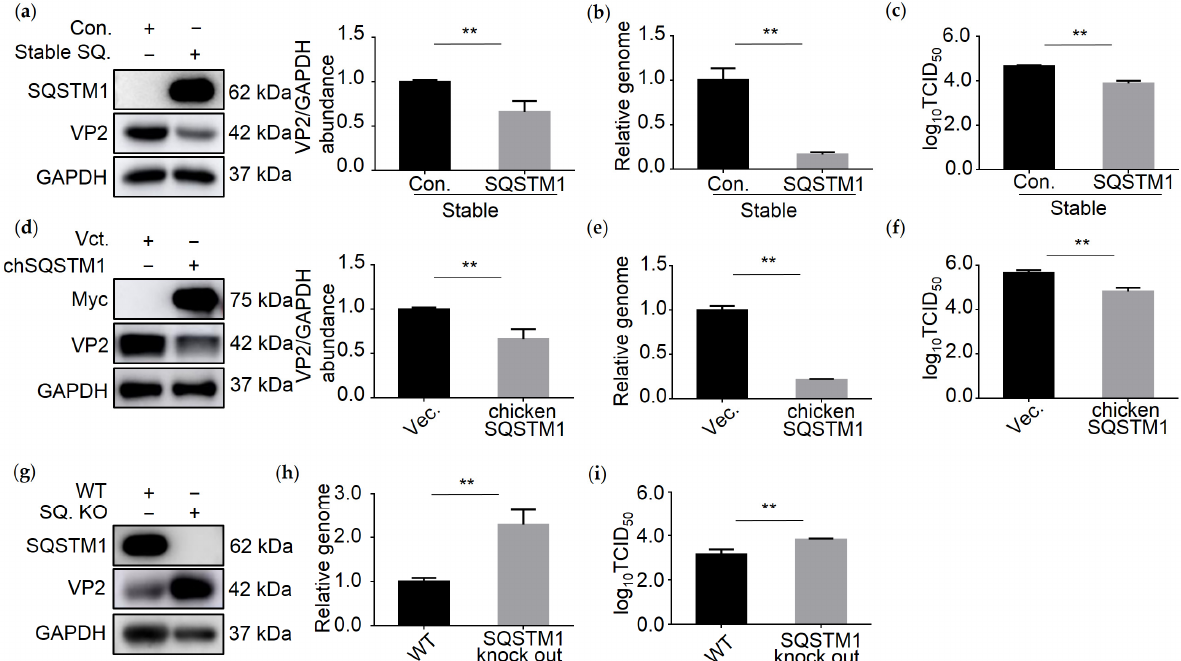
Figure 4. SQSTM1 overexpression, but not knockout, inhibits IBDV replication. ( a – c ) Stable expression of SQSTM1 in 293T cells inhibited IBDV replication. Stable 293T cells expressing SQSTM1 (Stable SQ.) were infected with IBDV at MOI = 0.1 for 18 h. The cells were collected and equally divided into three parts. IBDV viral protein VP2 was measured by Western blot ( a ). IBDV dsRNA and β -Actin mRNA from 293T cells expressing SQSTM1 were analyzed by qRT-PCR ( b ). The IBDV